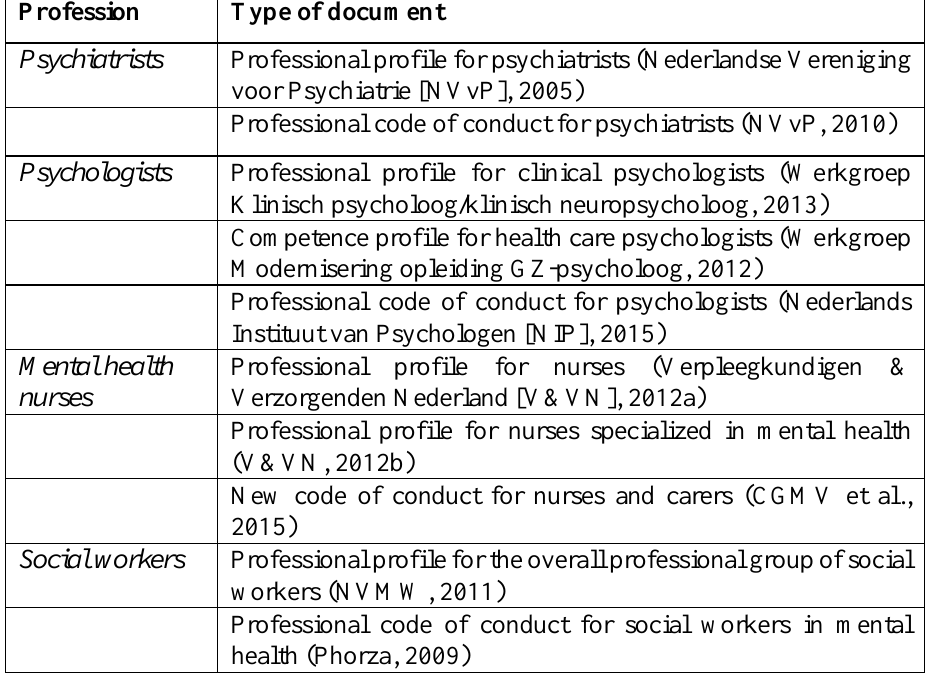
Selection of formal professional frameworks used in this study